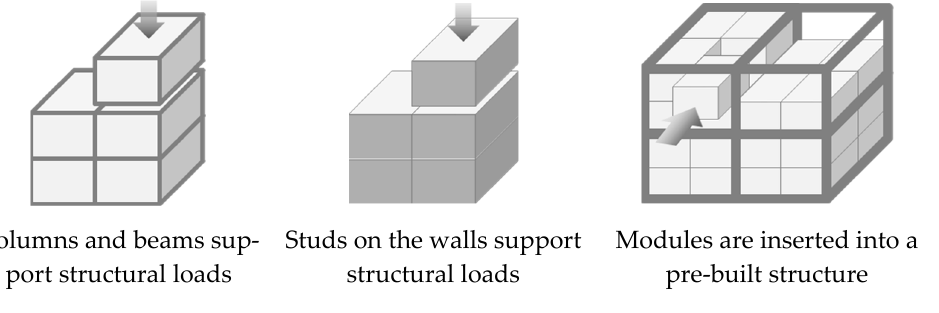
Figure 1. Modular construction methods [27]